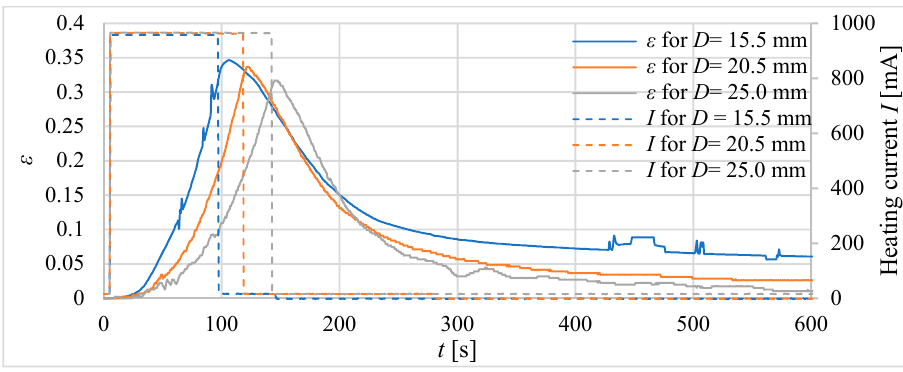
Figure 13. Relative elongation ε for actuators of equal length and different diameters.